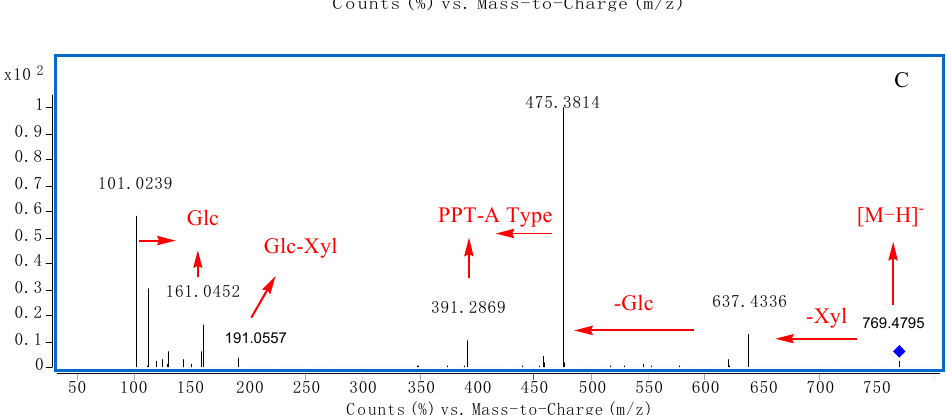
Figure 4. The typical TOF-MS spectra and fragmentation pathways of compound 72 . ( A ) MS spectrum in negative mode; ( B ) MS spectrum in positive mode; ( C ) MS/MS spectrum in negative mode. [M − H] − ( m/z 961.5409) and [M + COOH] − ( m/z 1007.5460) peaks of compound 25 were observed